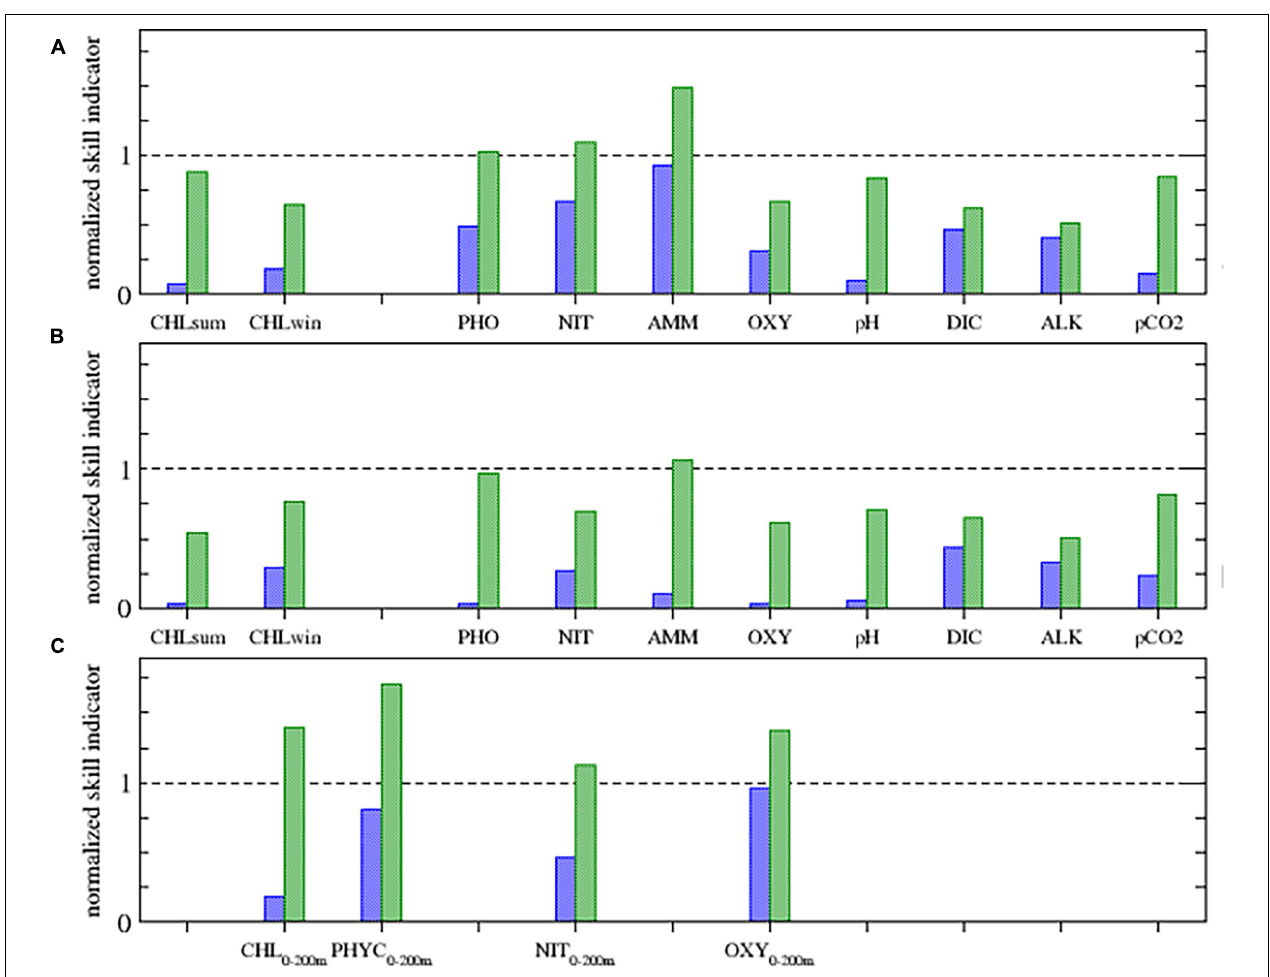
FIGURE 8 | Synthesis of validation Level 1 and 2 for 10 reanalysis variables with related emergent properties metrics in terms of the cost function (blue) and normalized RMSD (green): (A) Level 1 computed for the whole Mediterranean Sea 10–30 m layer (surface for chlorophyll summer and winter values, and for pCO 2 ). Level 2 computed comparing reanalysis with (B) satellite (for surface chlorophyll summer and winter values) and EMODnet_int for the whole Mediterranean Sea 0–30 m layer and with (C) BGC-Argo for chlorophyll, phytoplankton biomass, nitrate and oxygen 0–200 m averaged